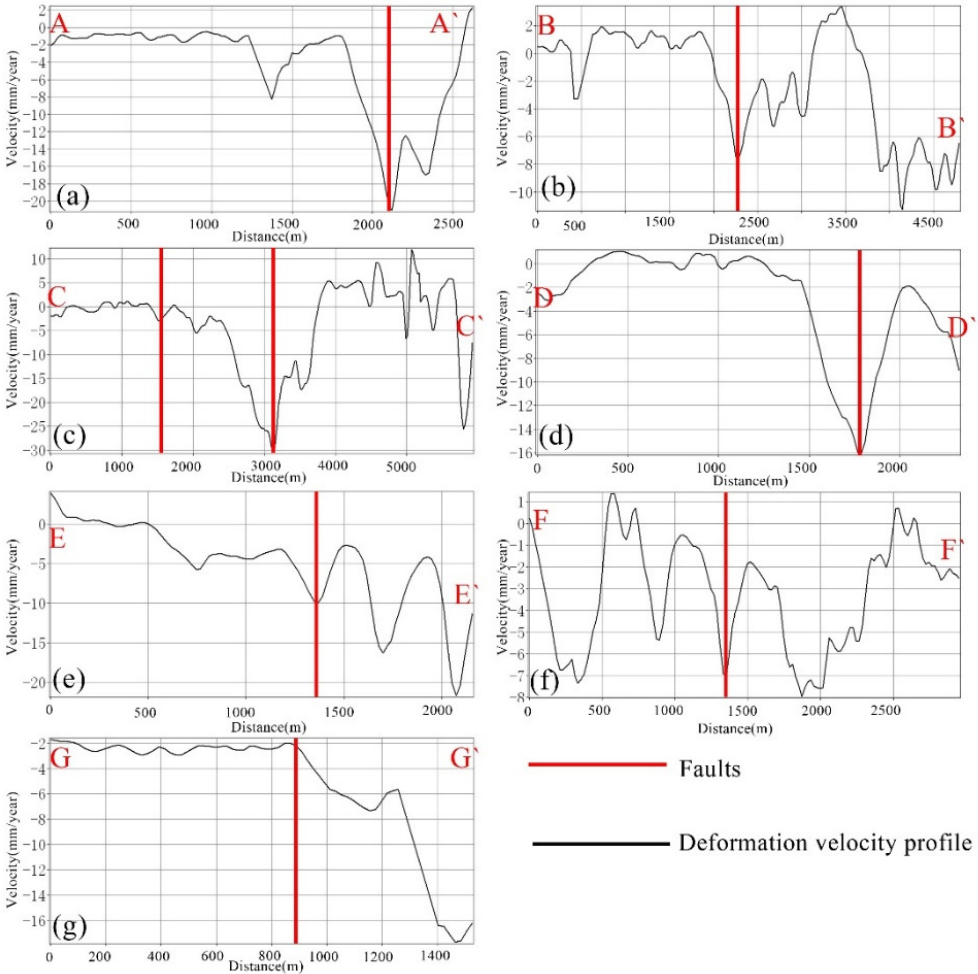
Figure 12. Relationship between surface deformation and geological faults (red line shows the fault lines). ( a ) deformation velocity for the A-A’ profile, ( b ) deformation velocity for the B-B’ profile, ( c ) deformation velocity for the C-C’ profile, ( d ) deformation velocity for the D-D’ profile, ( e ) deformation velocity for the E-E’ profile, ( f ) deformation velocity for the F-F’ profile and ( g ) deformation velocity for the G-G’ profile.